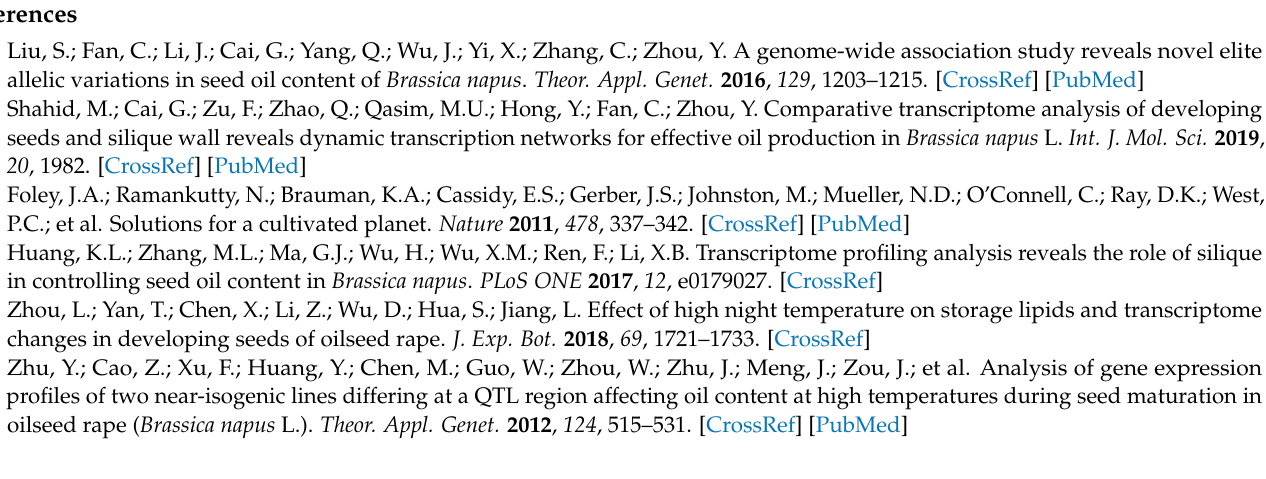
Figure S2: Relative retention time and intensity of 35 and 43 DAF medium- and long-chain fatty acid metabolites of WTSL and STSL in HNT. Figure S3: Analyses of major fatty acid contents based on medium- and long-chain fatty acid metabolites. Figure S4: Principal component analysis (PCA) score chart of the RNA-seq data of STSL in LNT. Figure S5: Principal component analysis (PCA) score chart of the RNA-seq data of STSL in HNT. Figure S6: Principal component analysis (PCA) score chart of the RNA-seq data of WTSL in LNT. Figure S7: Principal component analysis (PCA) score chart of the RNA-seq data of WTSL in HNT. Figure S8: GO functional annotation of DEGs of in 27, 35 and 43 DAF seeds in WTSL and STSL in LNT and HNT. Figure S9: Comparison between qRT-PCR and RNA-seq results for DEGs caused by LNT and HNT. Table S1: Major climate and environmental factors during growth period. Table S2: Effect of different altitudes on oil content and fatty acid composition in B. napus L. Table S3: Reads number based on the RNA-Seq data. Table S4: Analysis of DEGs from WTSL in HNT. Table S5: Analysis of DEGs from WTSL in LNT. Table S6: Analysis of DEGs from STSL in HNT. Table S7: Analysis of DEGs from STSL in LNT. Table S8: GO functional vs. STE13. Table S10: GO functional annotation on OSE18 vs. OFE18 vs. OTE18. Table S11: GO HNT. Table S13: KEGG enrichment in WTSL in LNT. Table S14: KEGG enrichment on STSL in HNT. Table S15: KEGG enrichment in STSL in LNT. Table S16: The primer design of genes. Table S17: The primer design of HB1 and KCS promoters. File S1: Predicted LTR elements in HB1 promoter from STSL by plantCare. File S2: Predicted LTR elements in HB1 promoter from WTSL by plantCare. File S3: Predicted LTR elements in KCS promoter from STSL by plantCare. File S4: Predicted the LTR elements in KCS promoter from WTSL by